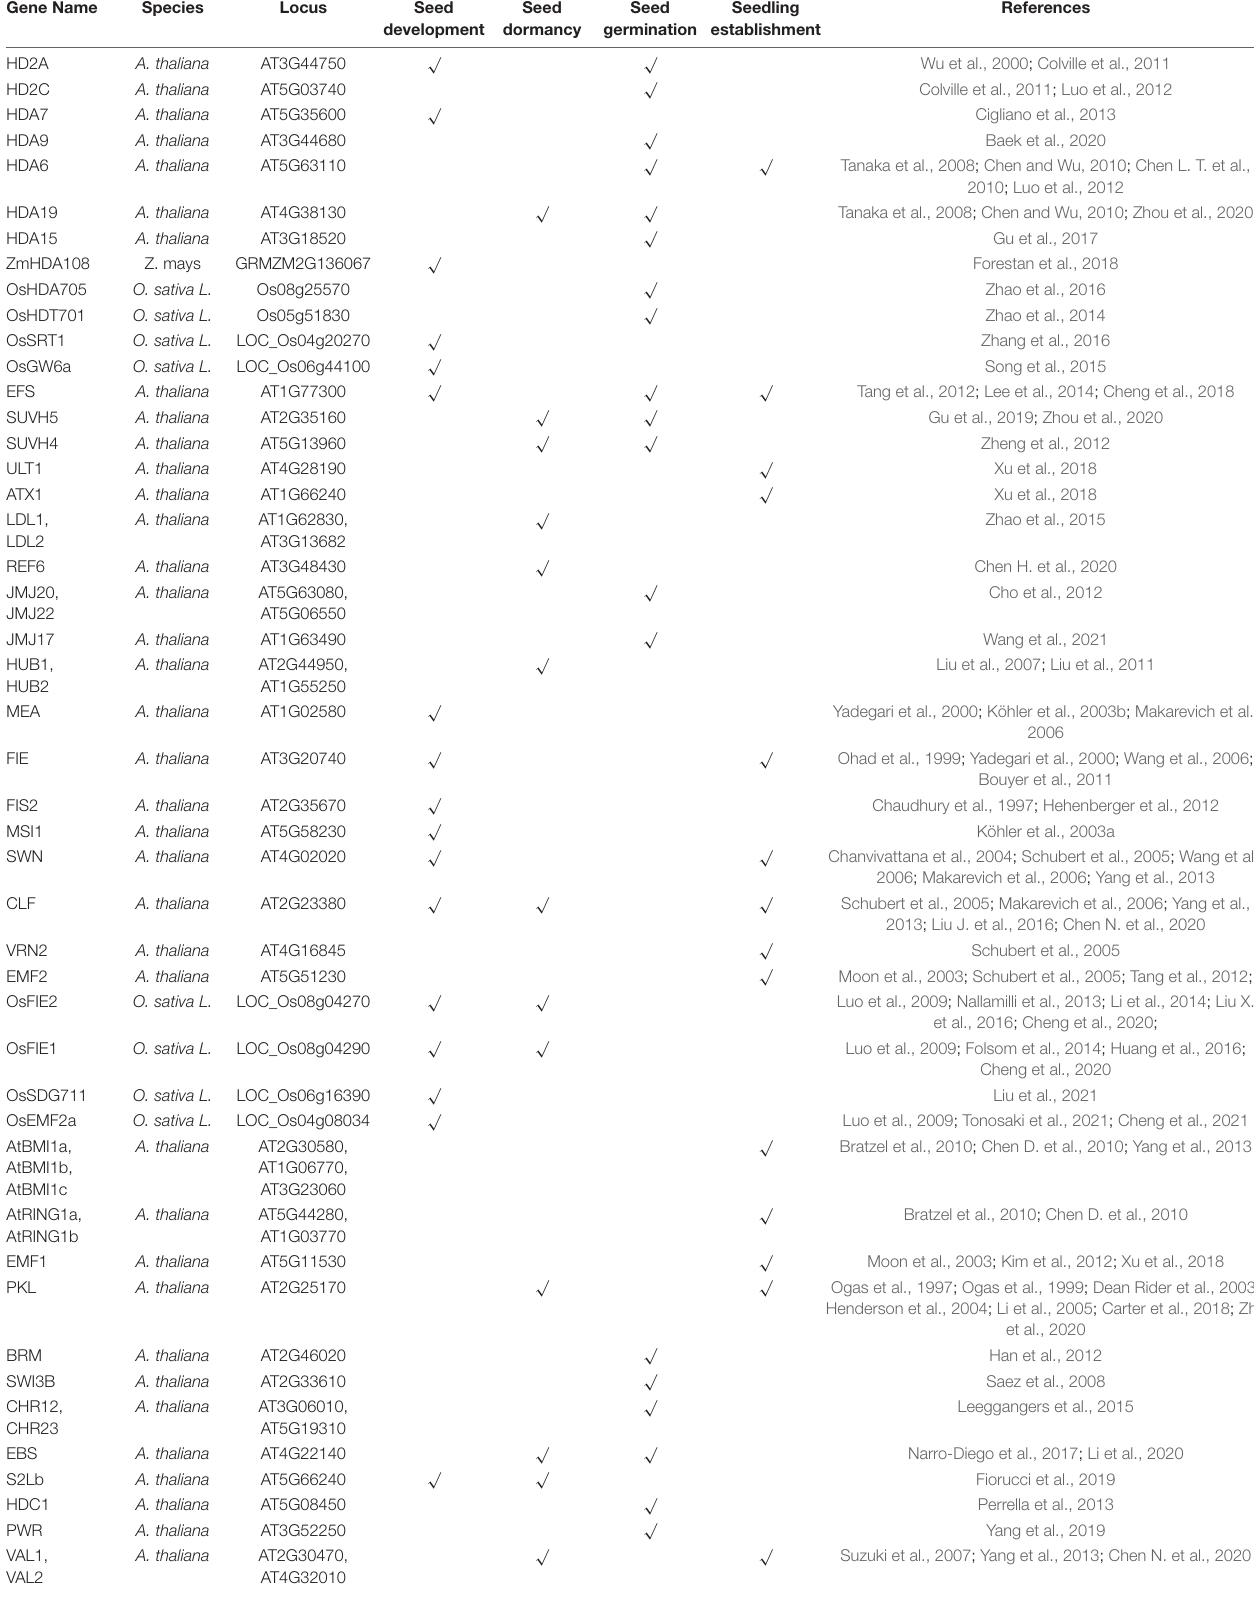
TABLE 1 | List of histone modifiers, chromatin remodelers and associated regulators involved in seed life cycle. Gene